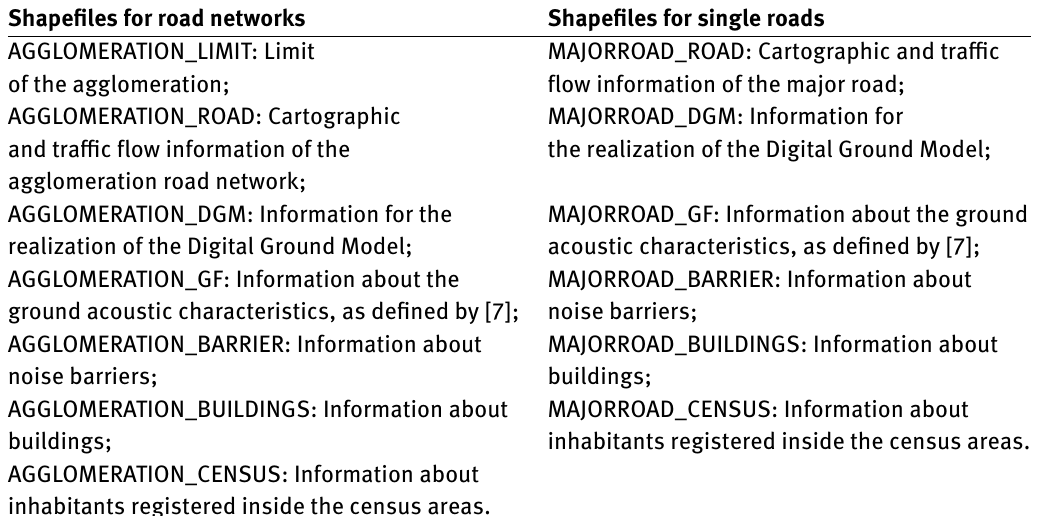
Shapefiles for road networks Shapefiles for single